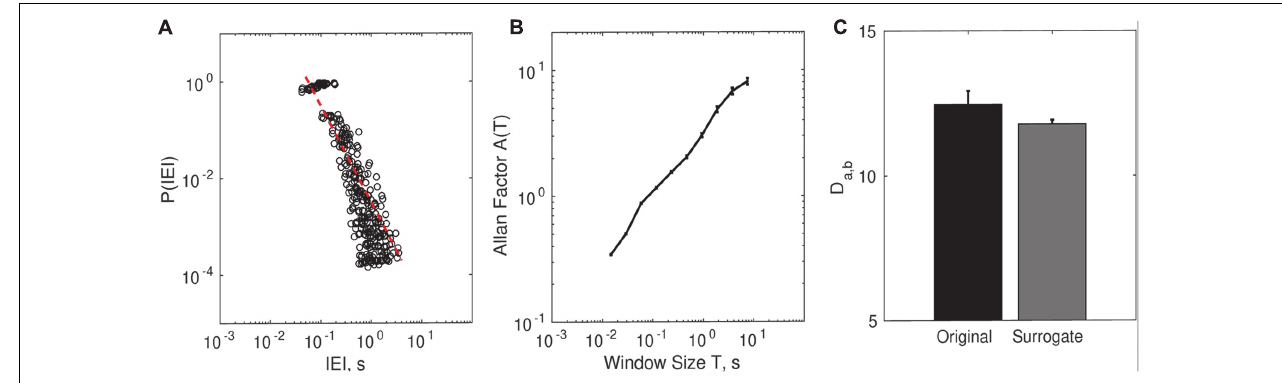
FIGURE 7 | Complexity matching in dyadic embodied social interaction. (A) The distribution of inter-event intervals (IEI) contains the bin-averaged probability P (IEI) for each participant . (B) The relation between Allan Factor and window size for each participant averaged (SE) across all subjects and all trials. (C) Complexity matching for all original dyad trials (15 trials × 17 teams) and surrogate dyad trials.